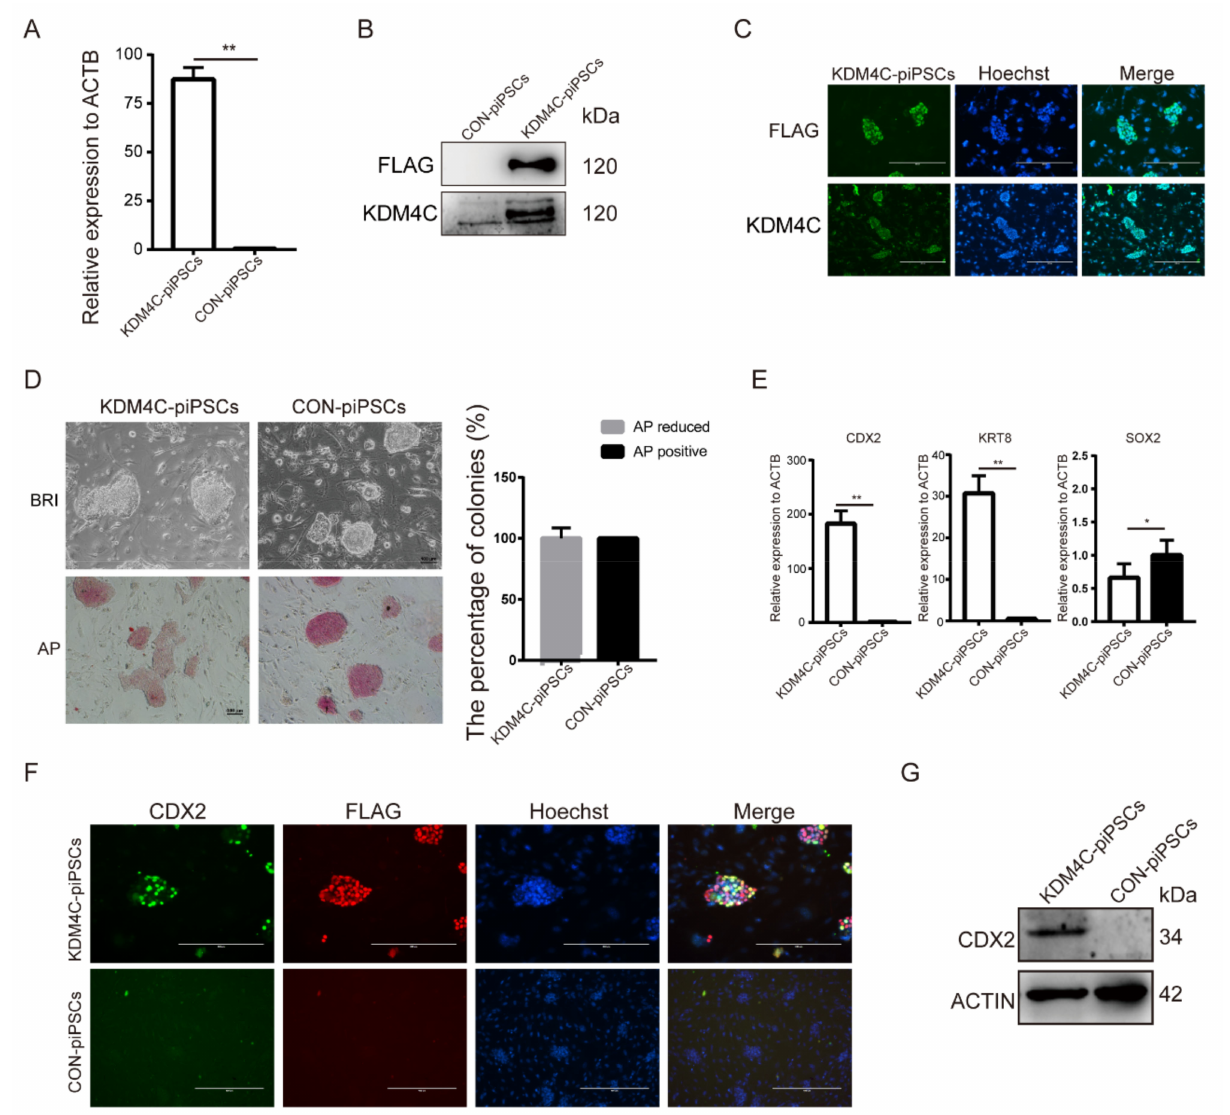
Figure 4. KDM4C activated the expression of CDX2. ( A ) qRT-PCR analysis of KDM4C in CON- and KDM4C-overexpressing piPSCs (KDM4C-piPSCs); ** represents p < 0.001. ( B ) Western blot analysis of the KDM4C and FLAG expression level in the CON- and KDM4C-piPSCs; ( C ) immunoflu- orescence analysis of KDM4C and FLAG in the KDM4C-piPSCs; the scale bar represents 400 µ m. ( D ) Representative image of bright-field and AP-stained colonies in the CON and KDM4C-piPSCs; the scale bar represents 100 µ m. ( E ) qRT-PCR analysis of CDX2, KRT8 and SOX2 in E-piPSCs in the CON and KDM4C-piPSCs; ** represents p < 0.001, * represents p < 0.05. ( F ) Immunofluorescence analysis of CDX2 and FLAG level in the CON- and KDM4C-piPSCs; the scale bar represents 200 µ m. ( G ) Western blot analysis of the CDX2 level in the CON- and KDM4C-piPSC.